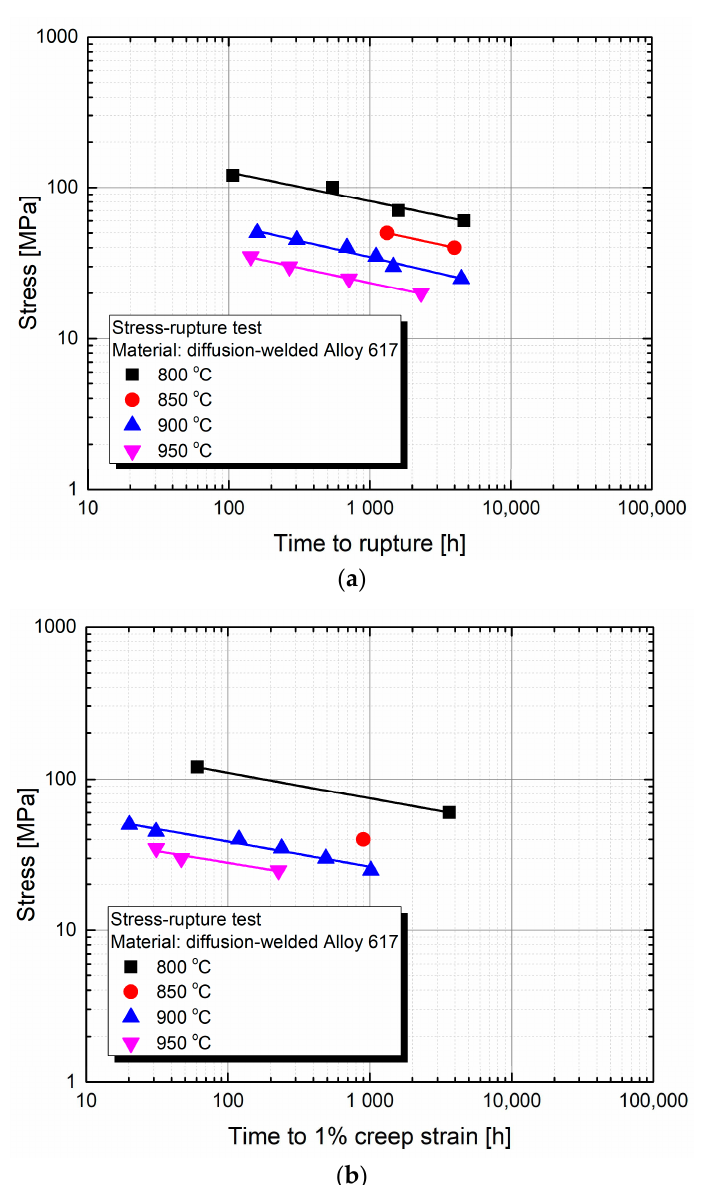
Figure 5. Double-logarithmic plots of stress versus time: ( a ) log stress versus log time to rupture and ( b ) log stress versus log time to 1% creep strain.